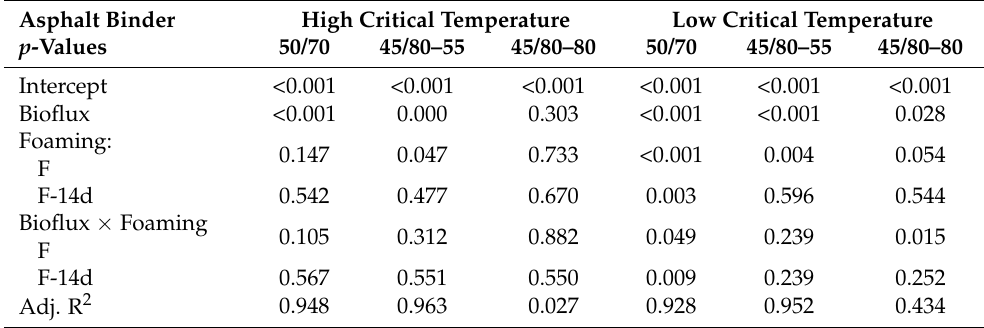
Table 5. The p -values calculated in analyses of variance for assessing the significance of the effects of Bioflux and foaming on the high and low critical temperatures of asphalt binders.